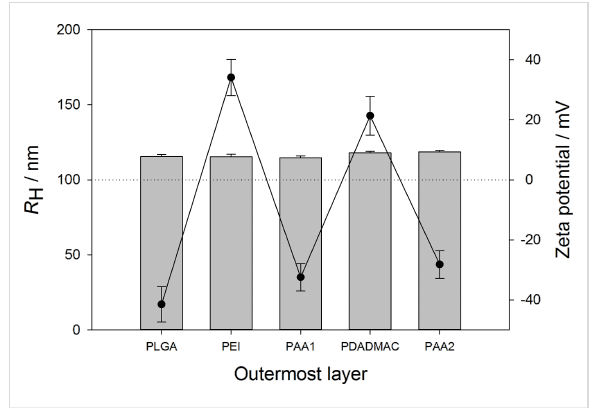
Figure 4: Hydrodynamic radii (bars) and zeta potential (line plot) in dependence of the number of polymer layers for the sequence PLGA- PEI(pH10)-PAA(pH5)-PDADMAC(pH9)-PAA(pH5). All experiments were performed in triplicate, average values ± standard deviations are shown.